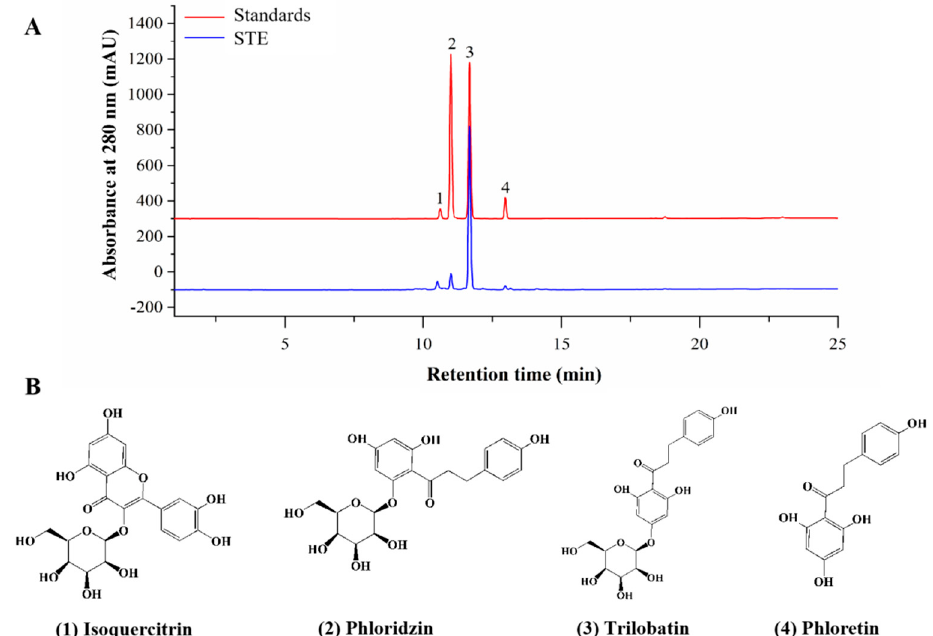
Figure 2. Phytochemical compounds of STE. ( A ) HPLC chromatograms of standards and sweet tea extract (STE) at 280 nm. The labeled number represents the compound: 1, isoquercitrin; 2, phloridzin; 3, trilobatin; and 4, phloretin. ( B ) The structures of isoquercitrin, phloridzin, trilobatin, and phloretin.